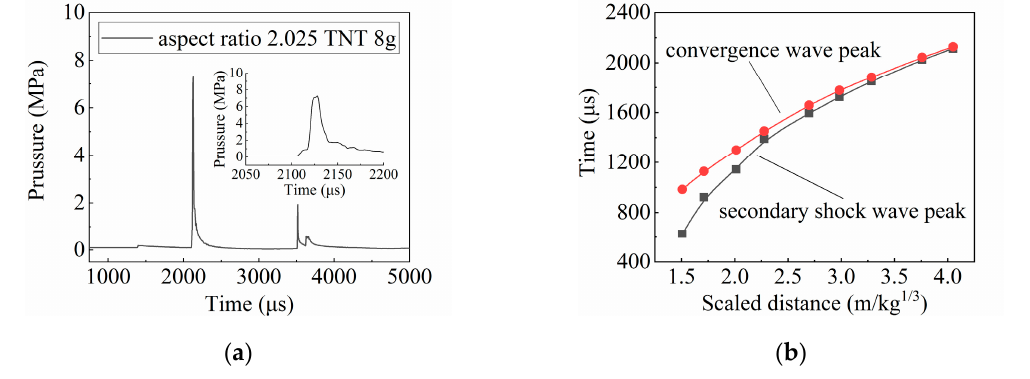
Figure 7. ( a ) The pressure curve at the pole under the 8 g charge. The detail is in the top right corner. ( b ) Time interval between the convergence wave peak (red dot solid line) and the secondary shock wave peak (black dot solid line) under the different charges.